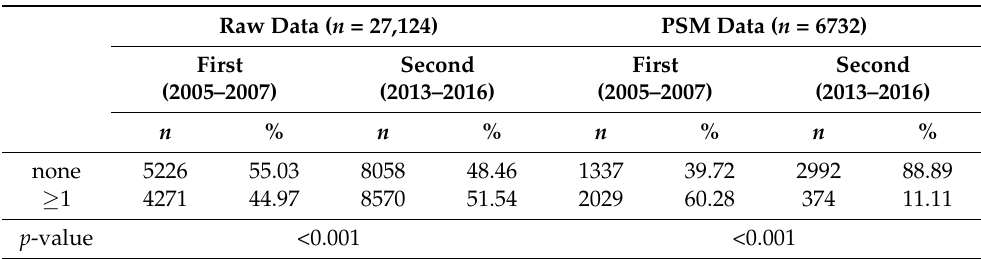
Table 2. History of induced abortion among women seeking induced abortion in two